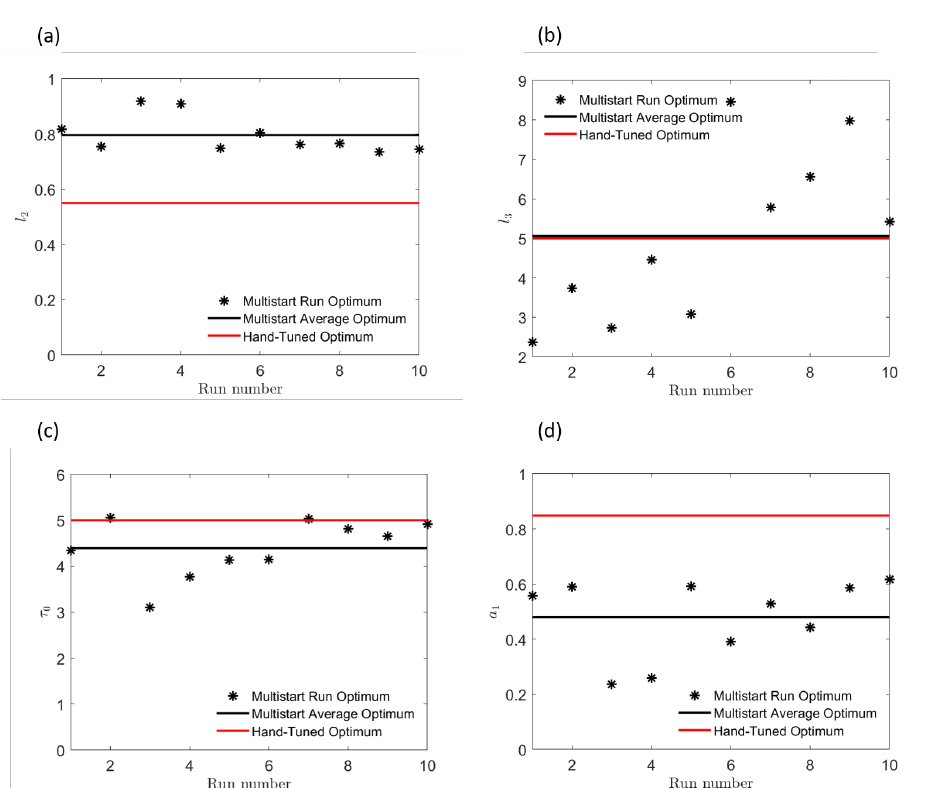
Figure 7. Parameter variance across 10 runs of Multi-Start ( a ) l 2 ( b ) l 3 ( c ) τ 0 ( d ) a 1 .